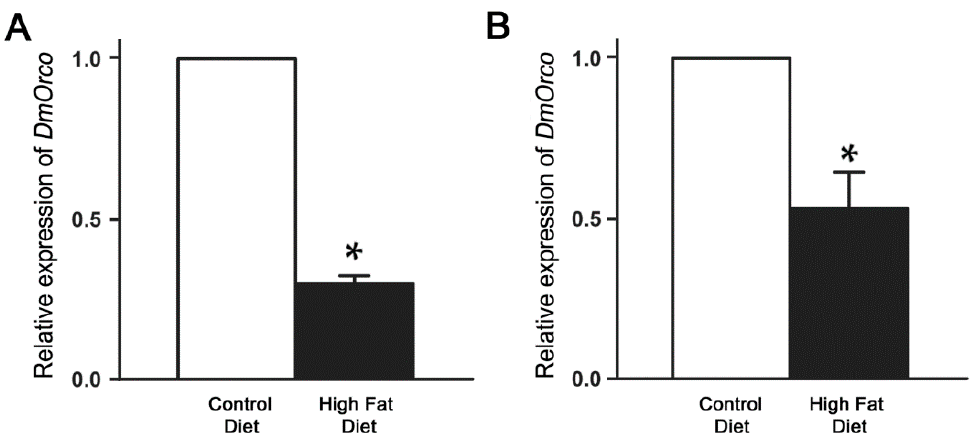
Figure 3. Relative expression of DmOrco in antenna of wild type Canton-S flies fed control diet and HFD for seven days and 14 days. ( A ) Relative DmOrco mRNA transcript levels after different food treatment for seven days. The level of DmOrco transcript was significantly reduced in HFD-fed flies 7 days after food treatment, showing an approximately 70% decrease compared with control flies. ( B ) Relative DmOrco mRNA transcript levels after different food treatment for 14 days. All qRT-PCRs were carried out in triplicate (* p < 0.05). Error bars represent SEM.